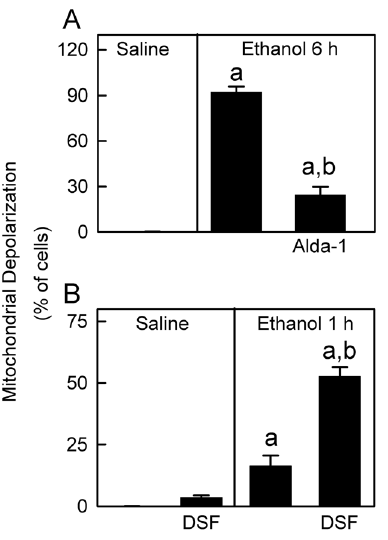
Figure 8. Role of aldehyde dehydrogenase in ethanol-induced mitochondrial depolarization. Mice were injected with vehicle, Alda-1 (50 mg/kg, i.p. ) or DSF (200 mg/kg, i.p. ) 30 min before gavage of saline or ethanol (6 g/kg), and Rh123 fluorescence was detected after 6 h ( A ) and 1 h ( B ), respectively. Values are means 6 SEM (n=4 per group). a, p , 0.05 vs saline; b, p , 0.05 vs ethanol without Alda-1 or DSF.